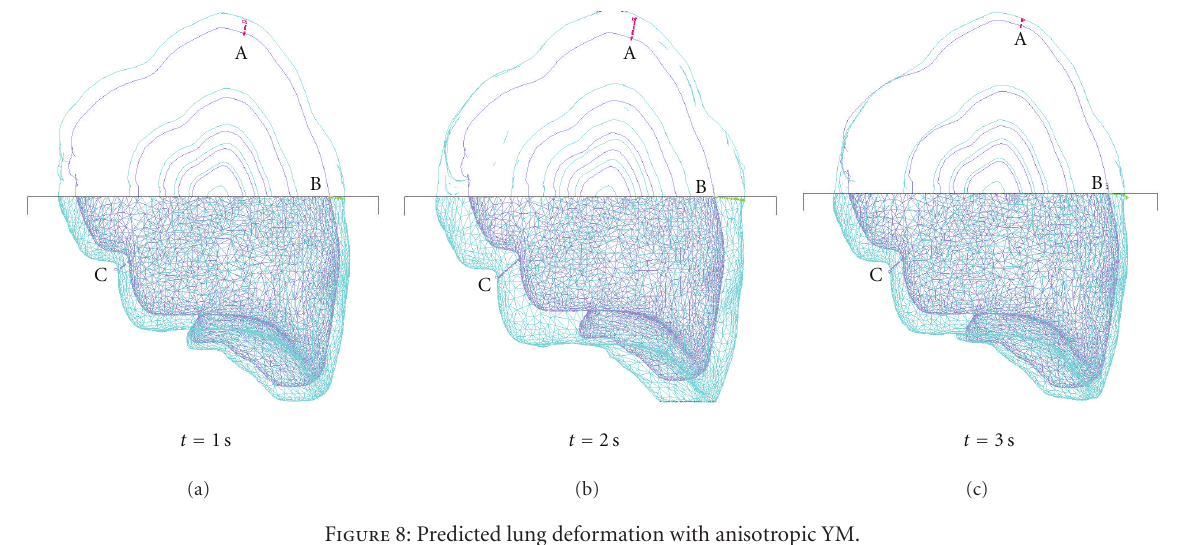
Figure 8: Predicted lung deformation with anisotropic YM.